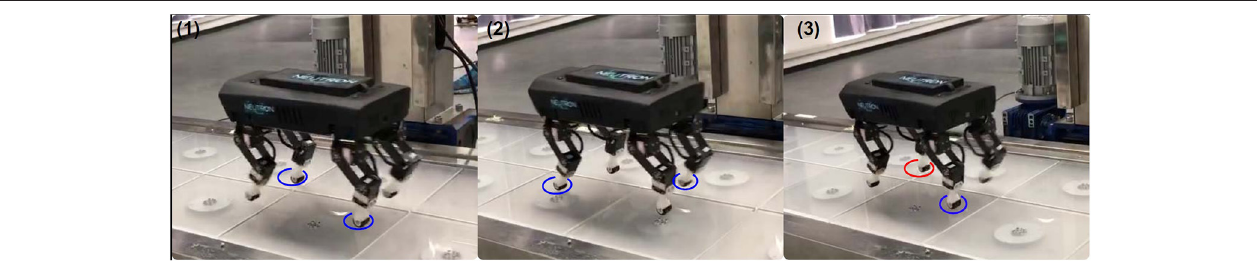
FIGURE 13 | Snapshot of the Lilibot walking on the force plate. The blue circles indicate the stance feet touching on a single measurement unit while the red circle indicate the feet (i.e., right front foot) touching on the boundary of two measurement units in which the force plate could not identify the GRF acted on the foot (i.e., right front